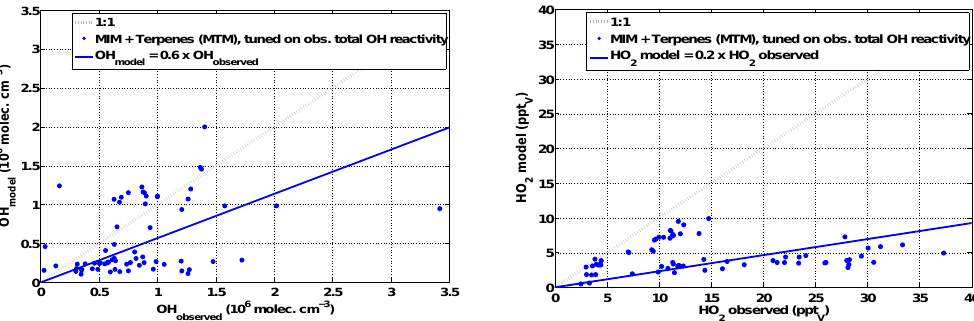
Fig. 12. Simulated vs. observed OH concentrations and HO 2 mixing ratios, applying the MIM3*+MTM chemistry scheme including terpene chemistry.